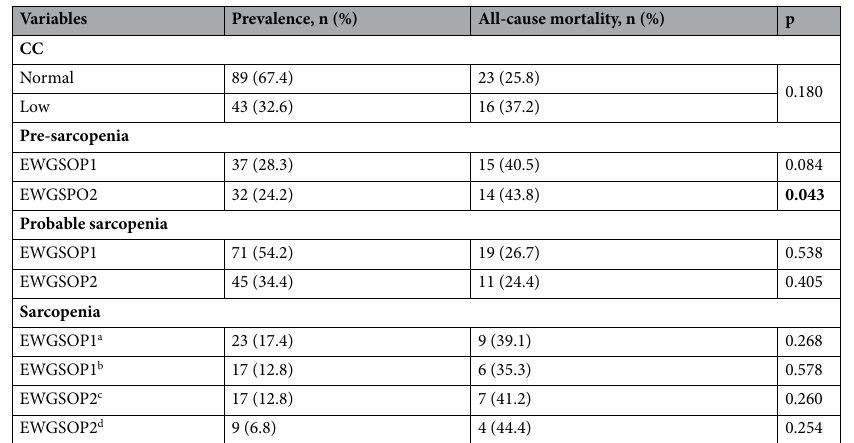
Table 1. Prevalence and factors associated with sarcopenia defined by the EWGSOP1 and EWGSOP2 criteria and two methods of measuring muscle mass (n = 132). EWGSOP European Working Group on Sarcopenia in older people, CC calf circumference, DXA X-ray double absorption bone densitometry, BMI body mass index, HDL high density lipoprotein (mg/dL) (high density lipoprotein), LDL low density lipoproteins (mg/dL) (low density lipoprotein), TG triglycerides (mg/dL), SD standard deviation, SMI skeletal muscle mass index. Significant values are in bold. Statistical analysis: independent t tests for continuous variables with a normal distribution, and the Mann–Whitney U test for continuous data with an abnormal distribution; and Pearson chi-square test or Fisher exact test (with the expected cell count of < 5) for categorical variables. *Class A (n = 1)